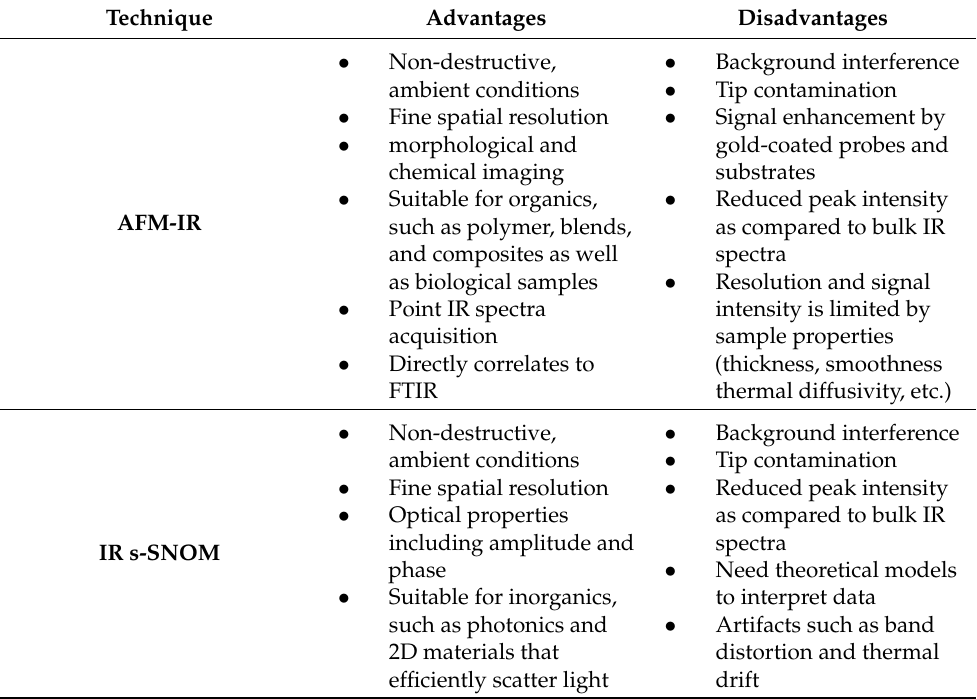
Table 1. Advantages and disadvantages of AFM-IR and IR s-SNOM